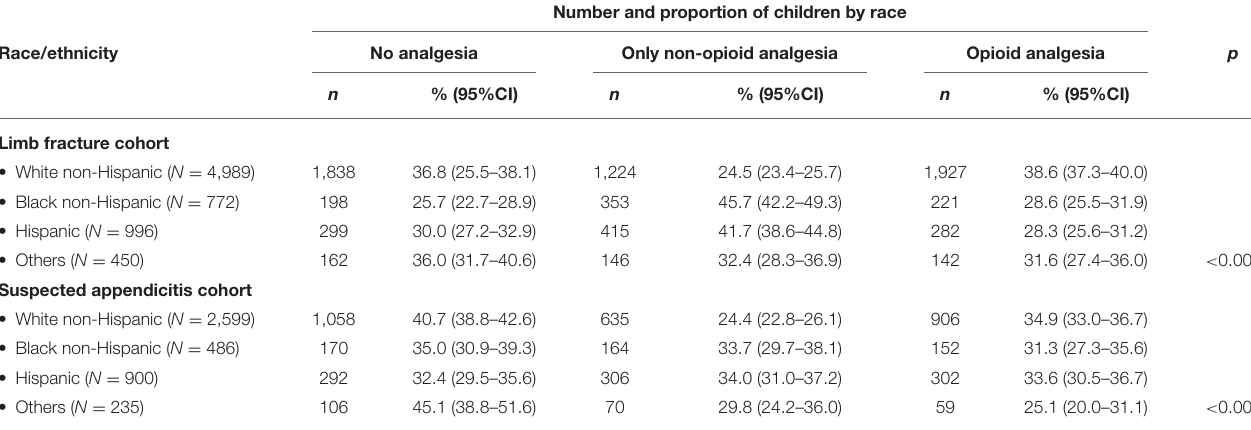
TABLE 2 | Unadjusted analgesia modalities by race/ethnicity for limb fracture and suspected appendicitis visits. Number and proportion of children by race Race/ethnicity No